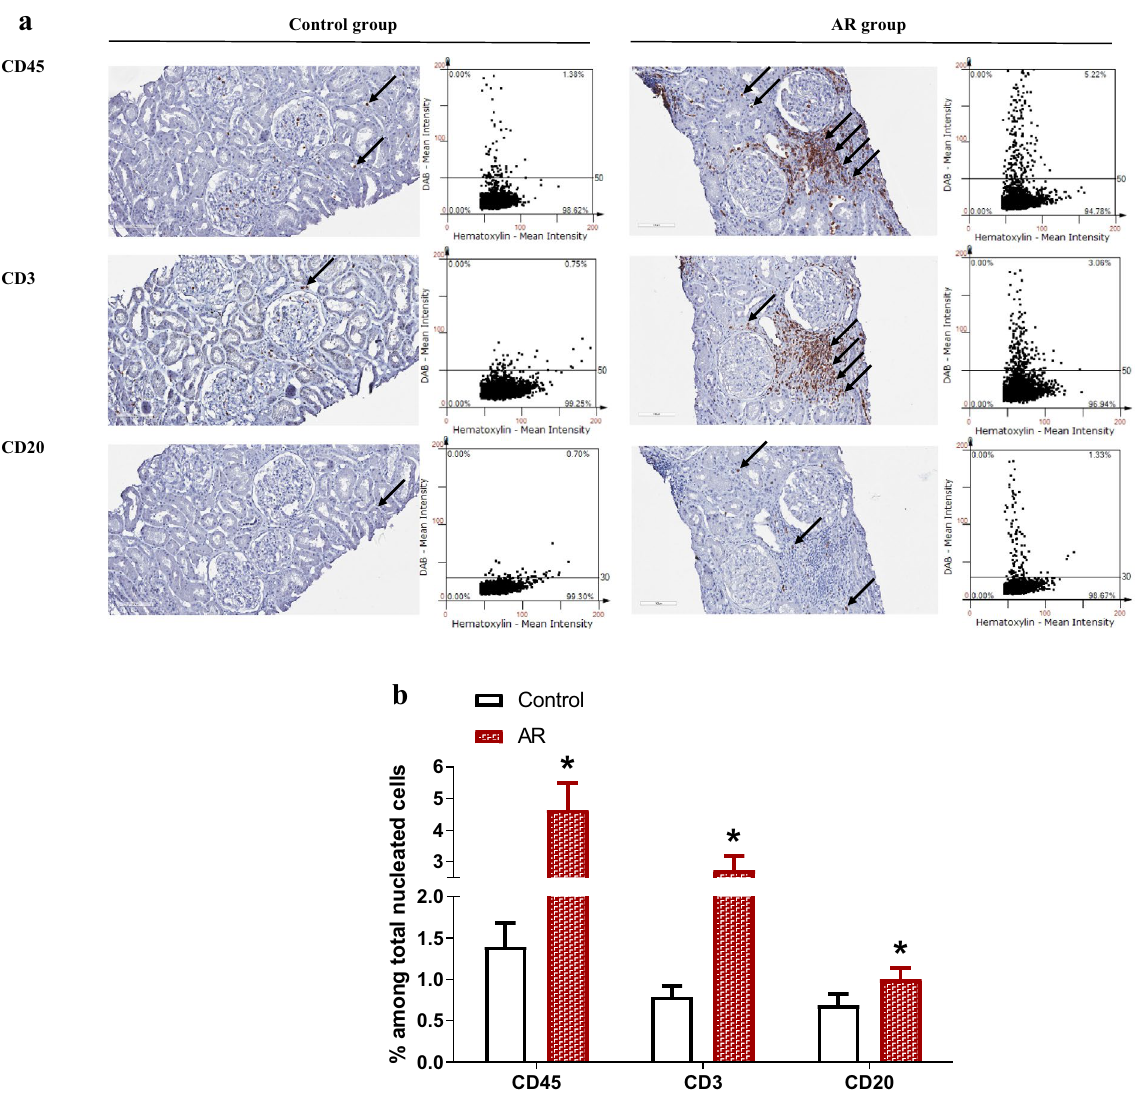
Figure 4. Semiquantitative analysis of intrarenal leukocytes infiltration. ( a ) Intrarenal infiltration of total leukocytes expressing CD45, T cells expressing CD3, and B cells expressing CD20 was compared with immunohistochemistry followed by semiquantitative analysis using tissueFAXS. Arrows indicate CD45-positive leukocytes, CD3-positive T cells, or CD20-positive B cells (×200). ( b ) The AR group displayed a significantly higher infiltration of total leukocytes, T cells, and B cells compared with the control group. * P < 0.05 compared with the control group. AR acute rejection, CD clusters of